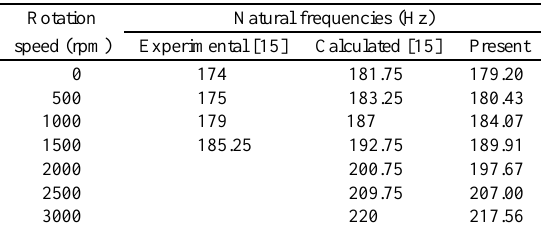
Table 3 Comparison of first harmonic